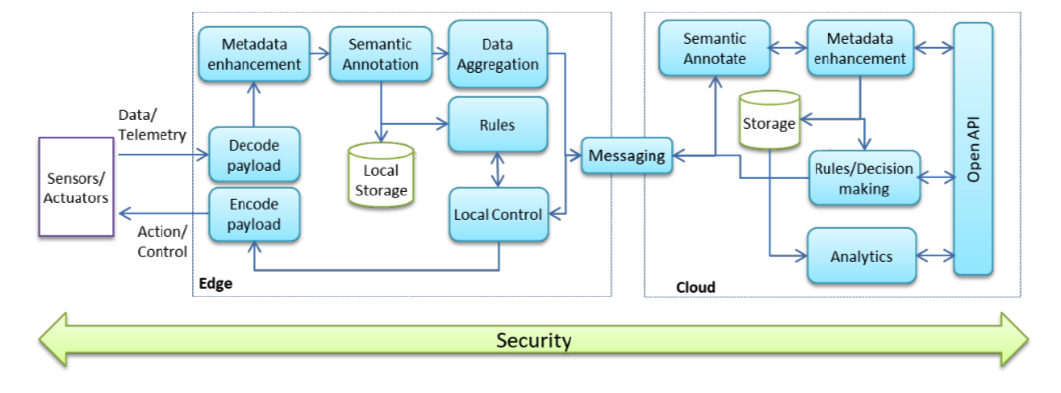
Figure 9. Subsystems Activities Overview.